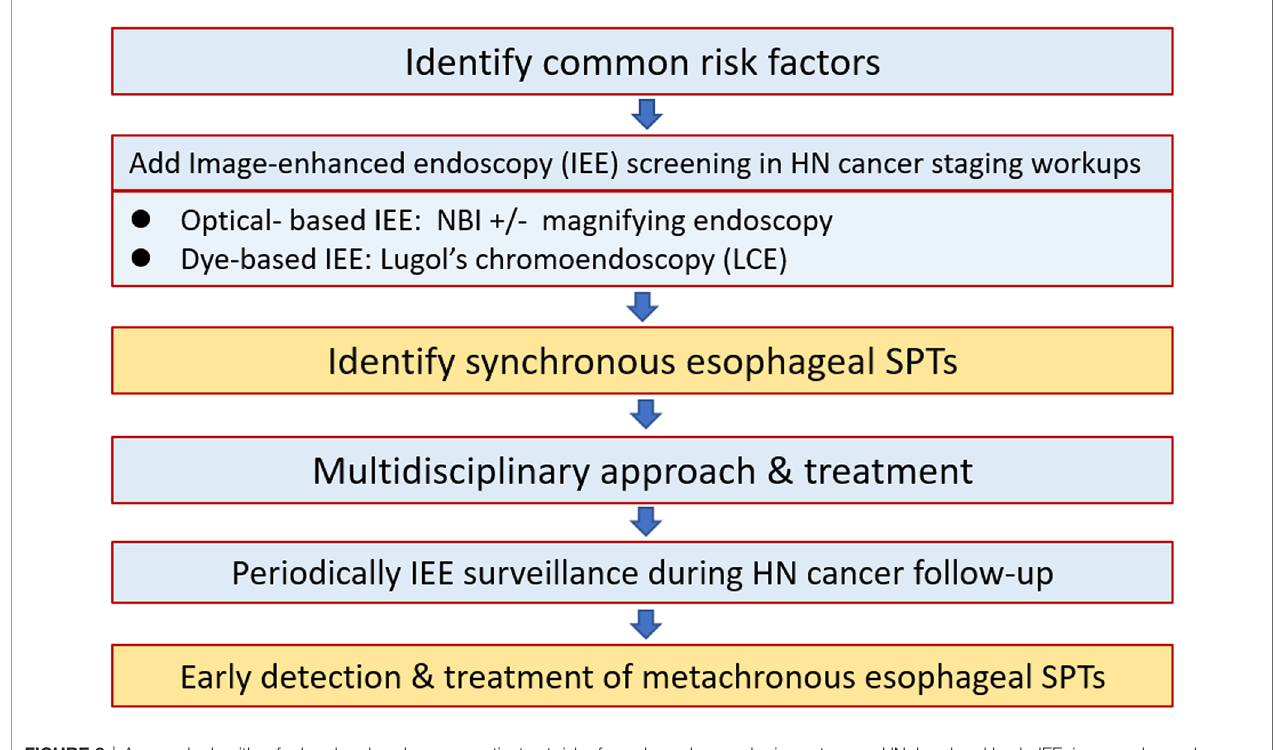
FIGURE 8 | Approach algorithm for head and neck cancer patients at risk of esophageal second primary tumors. HN, head and heck; IEE, image-enhanced endoscopy; LCE, Lugol ’ s chromoendoscopy; NBI, narrow-band imaging; SPT, second primary